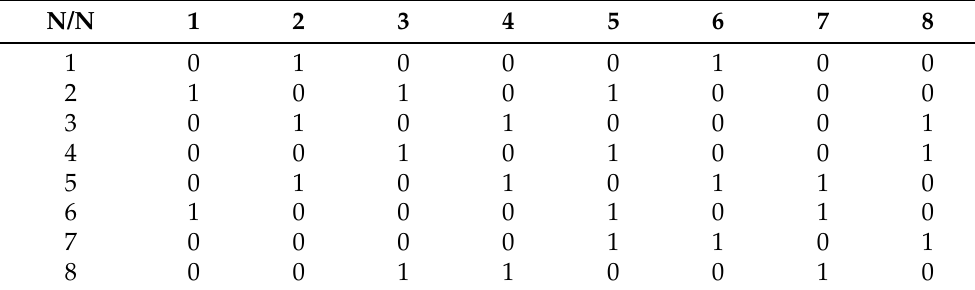
Table A6. Table representing matrix of network topology—incidence matrix topo n , m